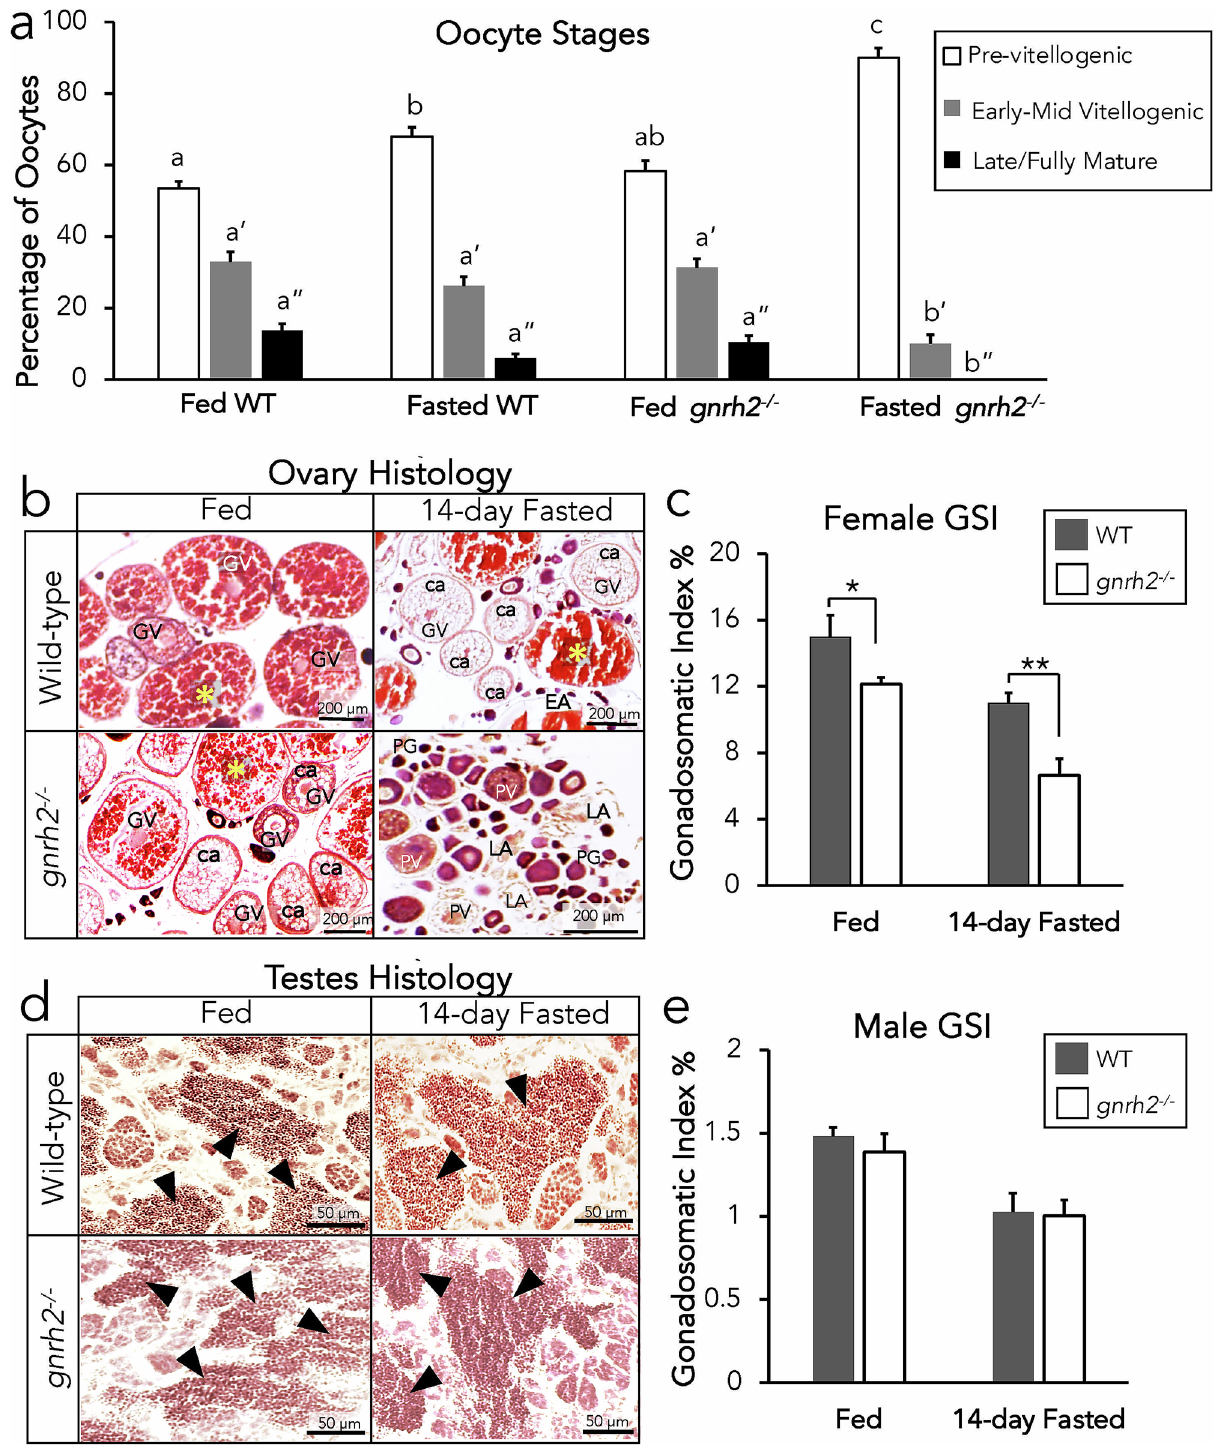
Figure 5. Gametogenesis analysis of knockout and WT zebrafish undergoing fed and fasted conditions. Percentage of oocytes at pre- vitellogenic, early-mid vitellogenic, and late/fully mature stages of WT and gnrh2 −/− ovaries after fed and fasted conditions demonstrate significantly fewer late/fully mature oocytes in gnrh2 −/− in fasted conditions (a). Histological sections of ovaries with labelled germinal vesicles (GV), cortical alveoli (ca), pre-vitellogenic oocytes (PV), and primary-growth follicles (PG), demonstrating fully mature oocytes (yellow star *) present in fed and fasted WT ovaries, but only present in fed gnrh2 −/− ovaries (b). GSI % quantification indicates reduced GSI in gnrh2 −/− undergoing fed and fasted conditions (c). Histological sections of testes demonstrate mature spermatozoa ▲ in fed and fasted WT and gnrh2 −/− males (d) with GSI % quantification indicating no difference in genotypes undergoing fed and fasted conditions (e). All data expressed as means ± S.E.M, n = 10 gonads per group, *P < 0.05, **P < 0.01, different letters indicate significant differences (P < 0.05) from each other (statistical comparisons made only between similarly-staged oocytes which are characterized by quote marks: no mark = pre-vitellogenic, ‘ = early-mid vitellogenic, ‘’ = late/fully